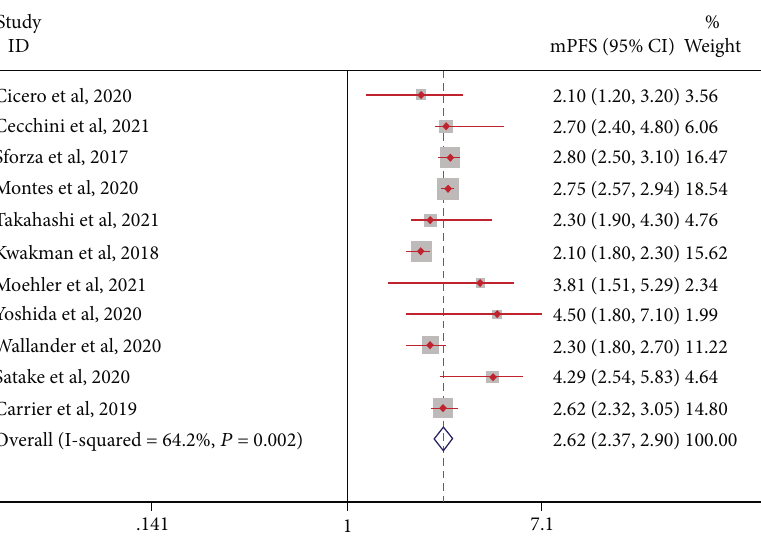
Figure 5: mPFS in patients with metastatic colorectal cancer treated with TAS-102 monotherapy or combination therapy with bevacizumab.